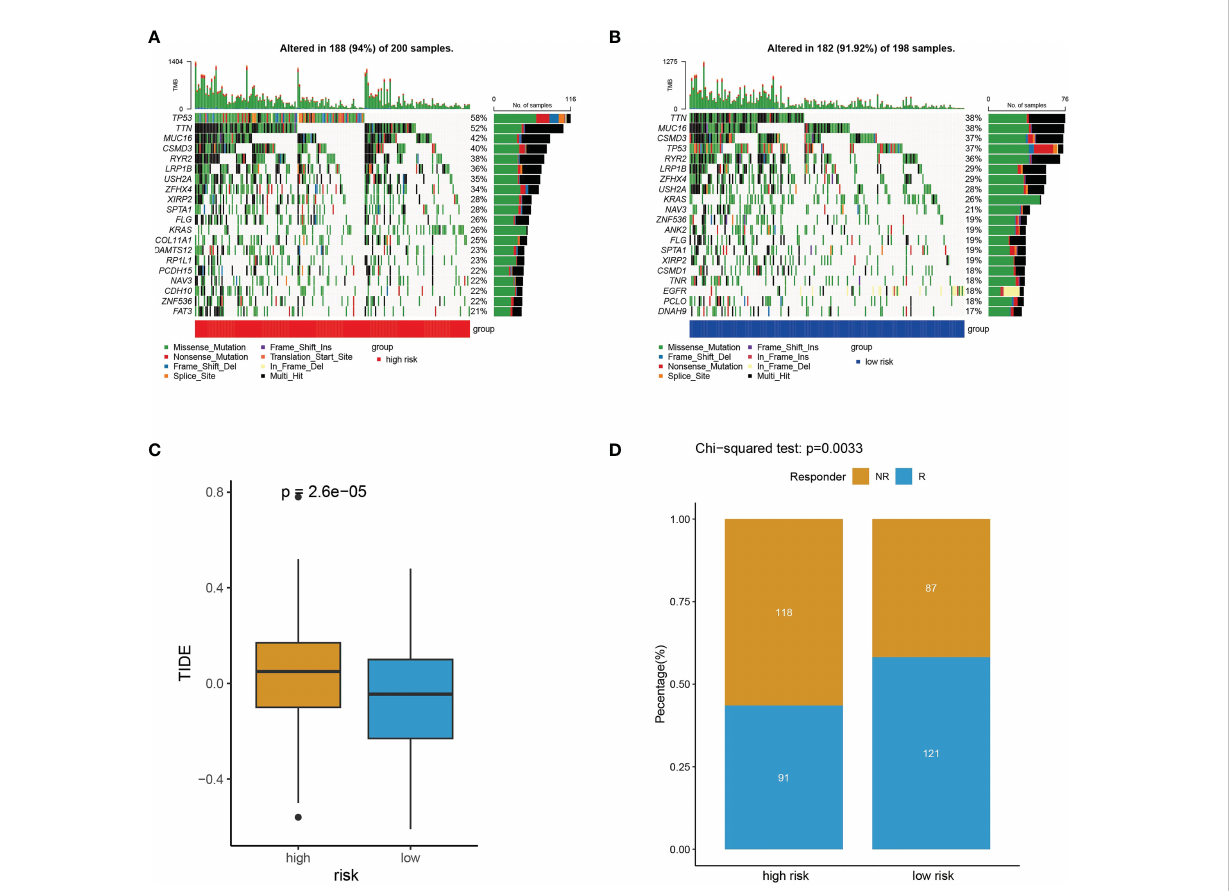
FIGURE 11 Somatic mutation frequency and immunotherapy response analyses. (A, B) The top 20 genes with the highest somatic mutation frequency in high- risk subtype (A) and low-risk subtype (B) . (C) TIDE prediction scores for immunotherapy response in the high- and low-risk subtypes. (D) The difference of high- and low-risk subtypes between non-responders (NR) and responders